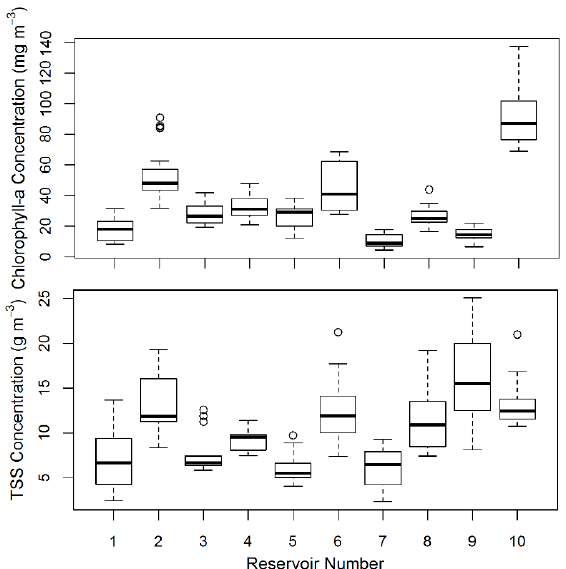
Figure 4. Concentrations of TSS and chl-a in all reservoirs collected throughout the study period. The boxplots represent first quartile, median, and third quartile. Whiskers represent 95% confidence interval of data, and open circles represent outliers.